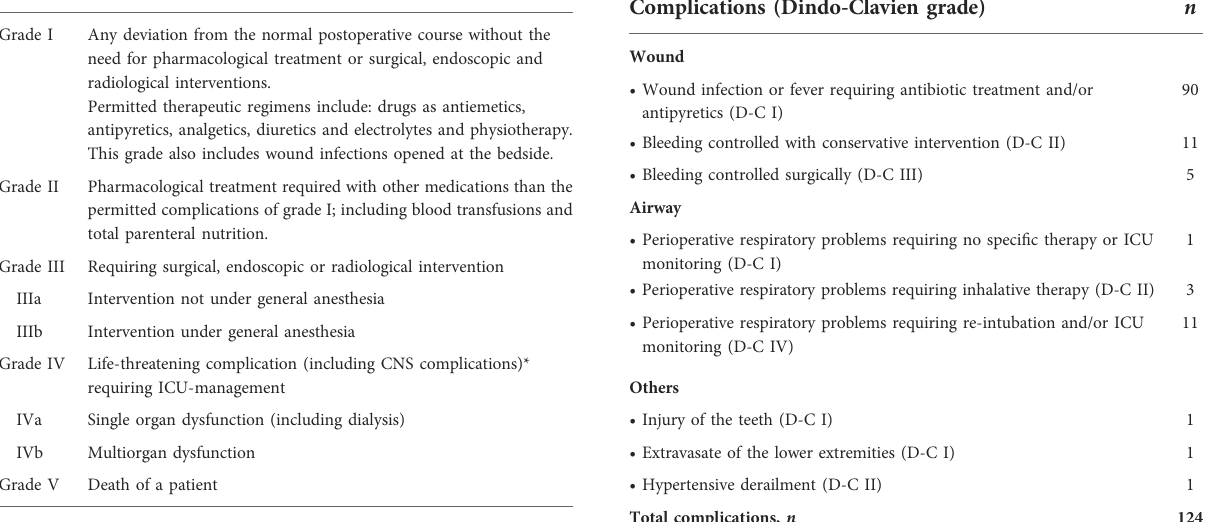
TABLE 1 Dindo-clavien classi fi cation of complications. Dindo-Clavien classi fi cation